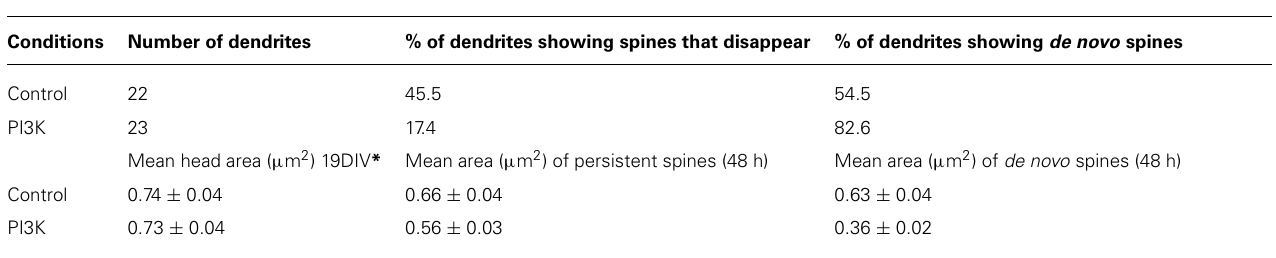
Table 4 | Summary of the analysis of spine turnover and the measurement of spine head areas in hippocampal neurons in culture. Conditions Number of